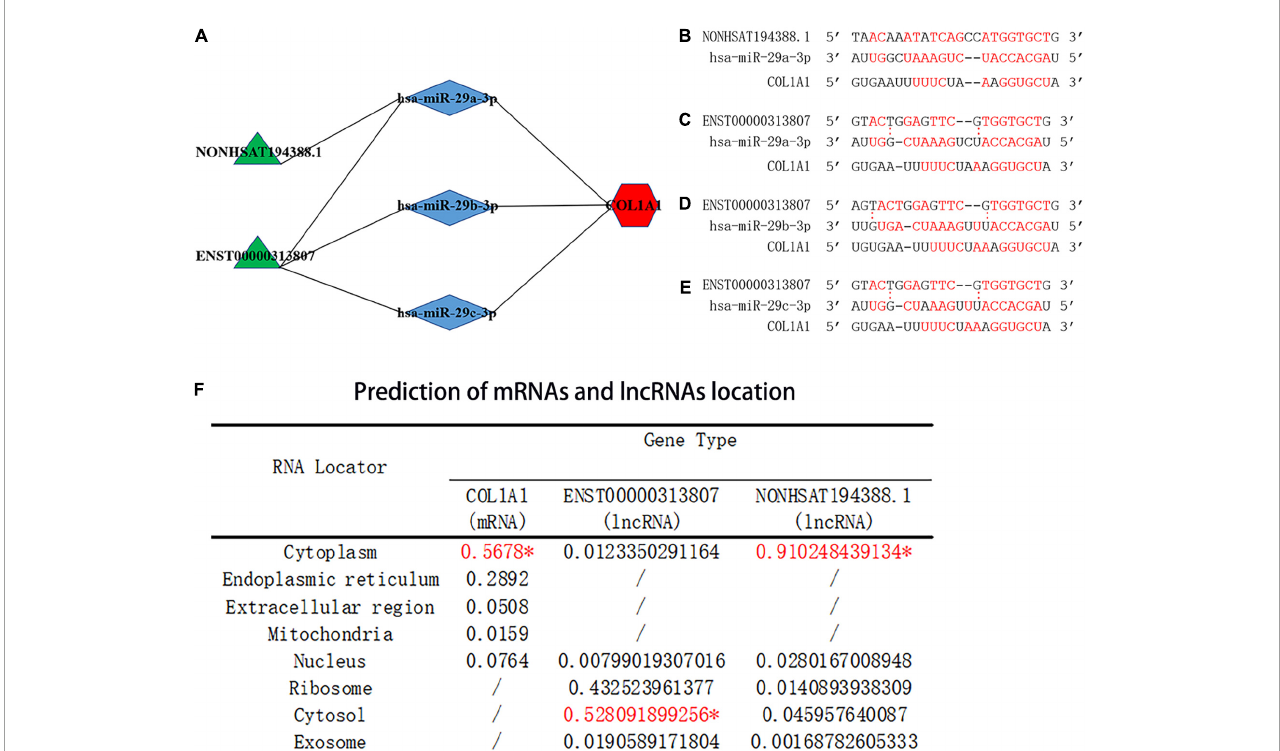
FIGURE9 Prediction of the binding sites and location of the ceRNA networks. (A) Prediction of ceRNA networks. Green parts are lncRNA, blue parts are miRNAs that interact with lncRNA and mRNA, and red parts are mRNA. (B) The red text represents binding sites of the NON-HSAT194388.1-hsa-miR-29a-3p- COL1A1 interaction network. (C) The red text represents binding sites of the ENST00000313807-hsa-miR-29a-3p- COL1A1 interaction network. (D) The red text represents binding sites of the ENST00000313807-hsa-miR-29b-3p- COL1A1 interaction network. (E) The red text represents binding sites of the ENST00000313807-hsa-miR-29c-3p- COL1A1 interaction network. “:” Means that the bond is not firm, and the red font means that the bond is stable. (F) Prediction of miRNA and lncRNA localization. The “ ∗ ” indicates the final predicted position on the